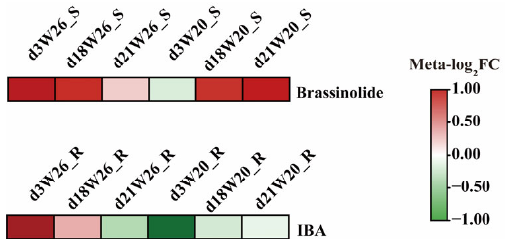
Figure 7. Heat map of relative expression of plant hormones. “d3W26_S” represents the leaves sampled by W26 on the 3rd day. “d18W26_S” represents the leaves sampled by W26 on the 18th day. “d21W26_S” represents the leaves sampled by W26 on the 21st day. “d3W26_R” represents the roots sampled by W26 on the 3rd day. “d18W26_S” represents the roots sampled by W26 on the 18th day. “d21W26_S” represents the roots sampled by W26 on the 21st day. “Meta” represents metabolite. “FC” represent “FoldChange”.